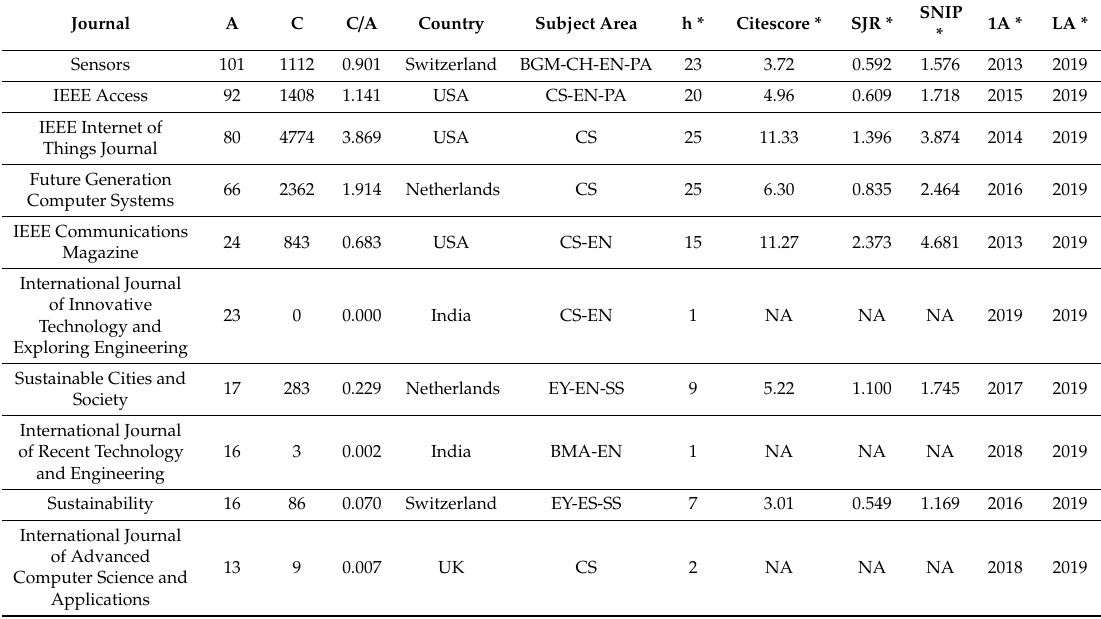
Table 2. Top 10 journals